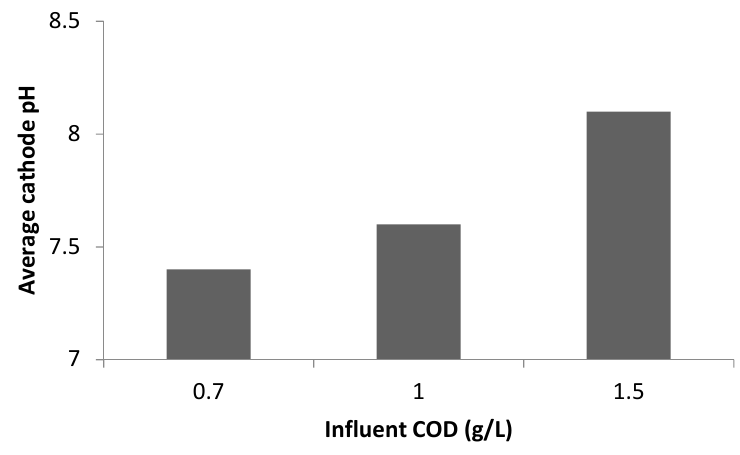
Figure 6. Impact of COD on current density, anode ORP, anode and cathode pH.